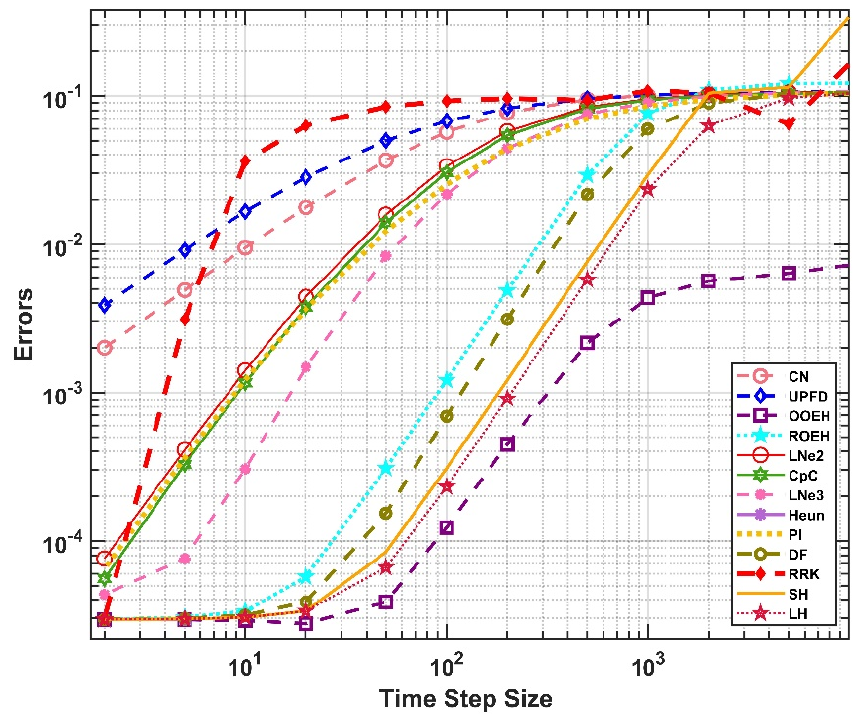
Figure 6. The maximum errors as a function of the time step size ∆ t for the abrupt change in the x -direction and gradual change in the z -direction.